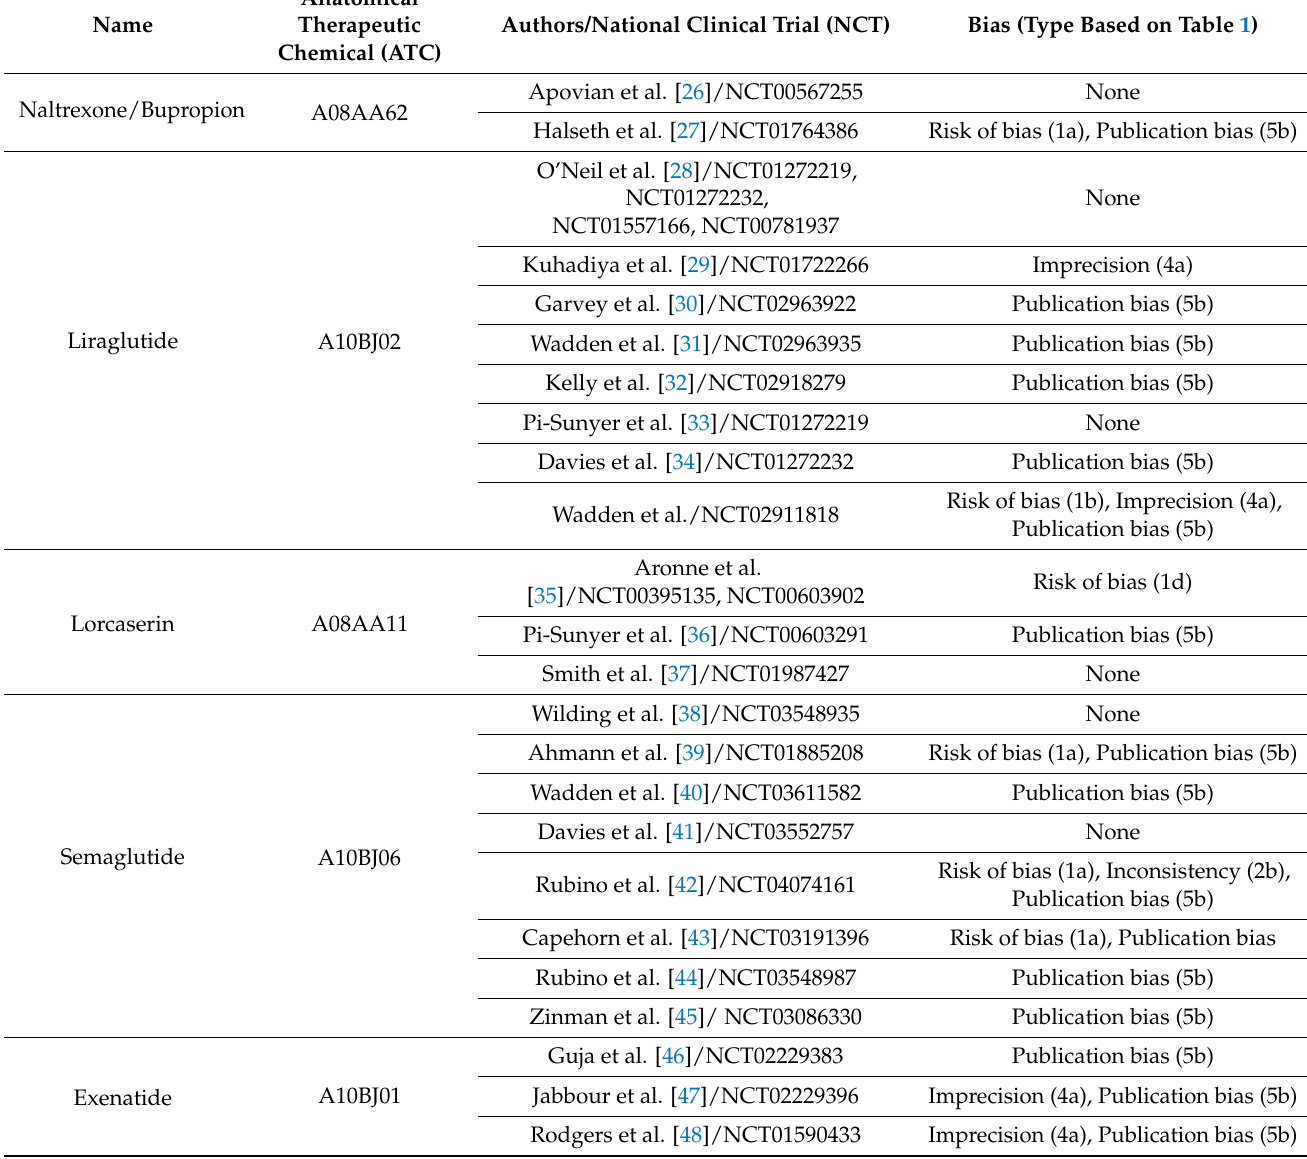
Table 2. Drugs, ATC, NCT, and the bias (limitations) found in each study. The factor contributing to bias according to Table 1 is indicated in